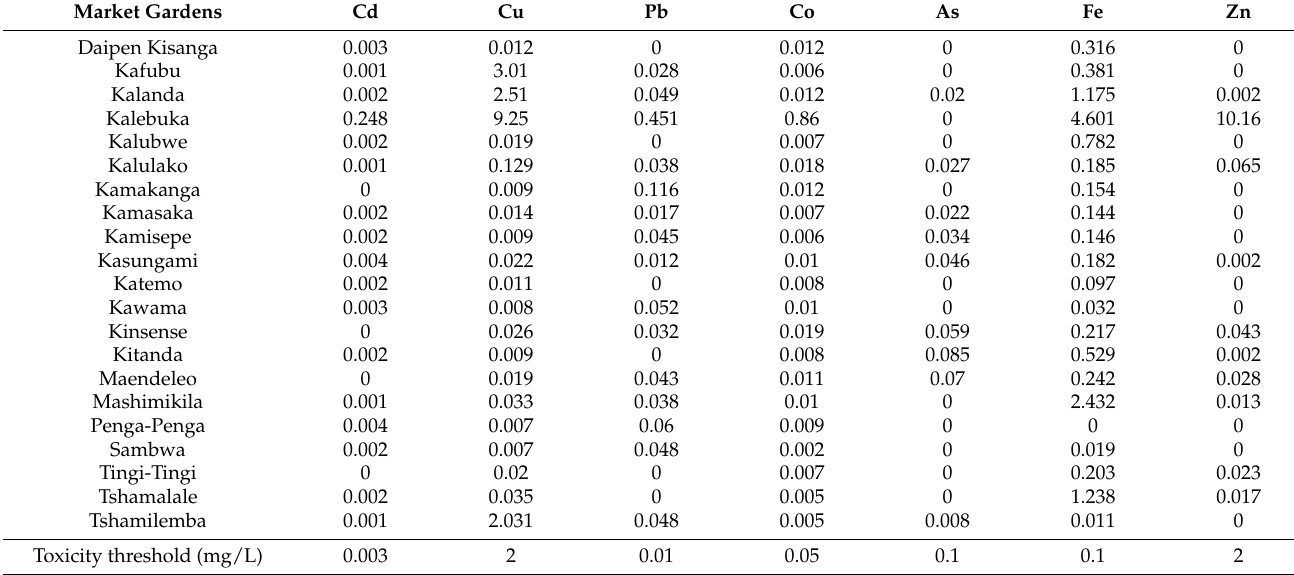
Figure 6. Spatial distribution of metals (Pb) in the market garden soils according to their contamina- tion factor ( A ) and enrichment factor ( B ). Table 4. Trace metal elements (mg/L) in the irrigation waters of the market garden crops of Lubum- bashi gardens. Legend: Cd, cadmium; Cu, copper; Pb, lead; Co, cobalt; Al, aluminum; As, arsenic; Fe, iron; Zn, zinc; bold figures, contents above the